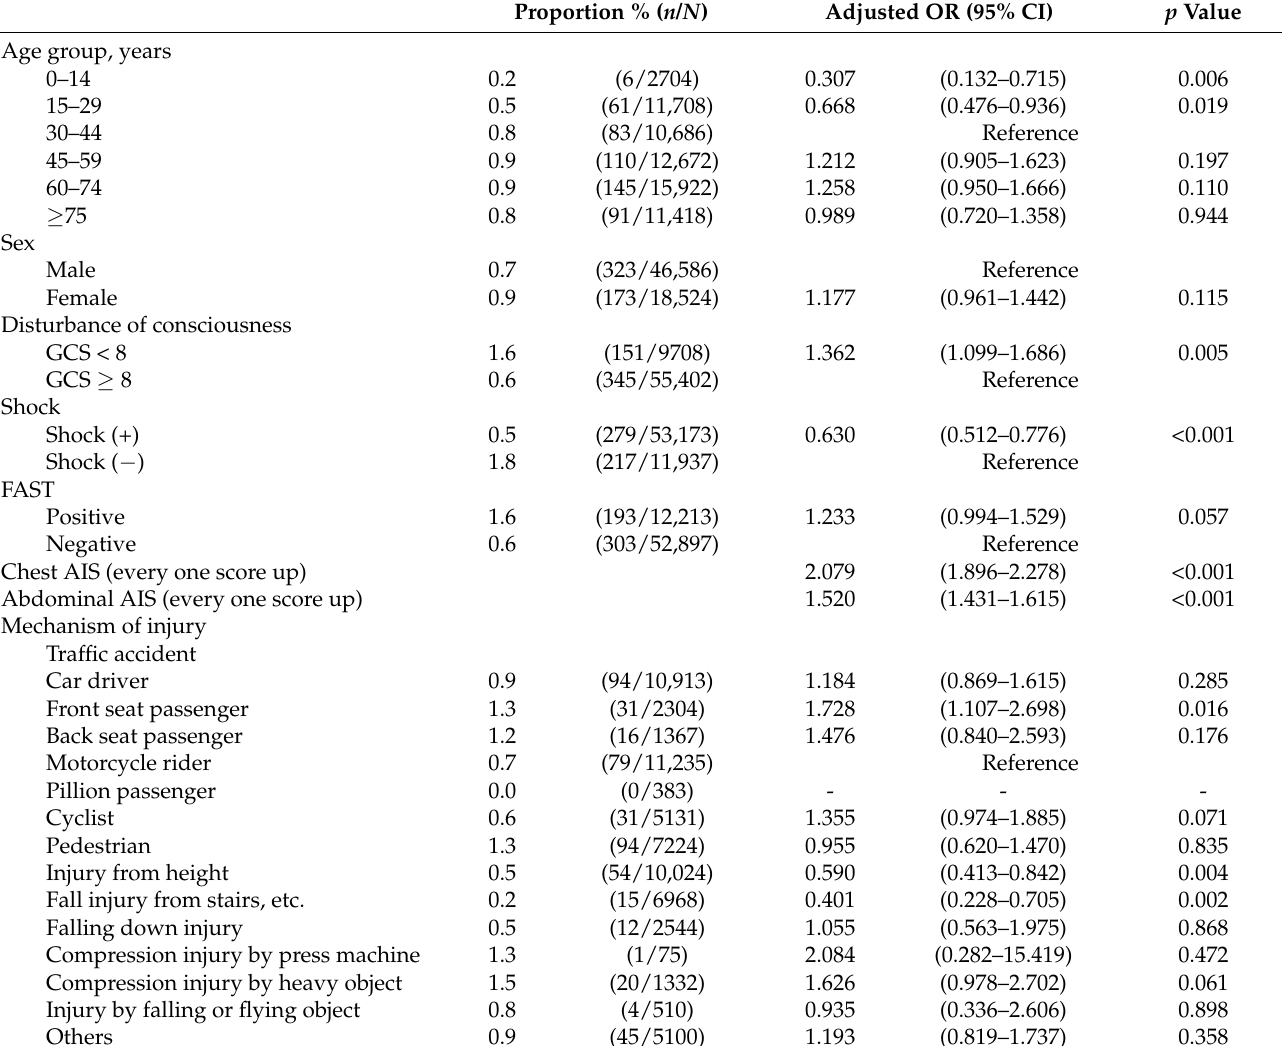
Table 2. Factors that were associated with traumatic diaphragmatic